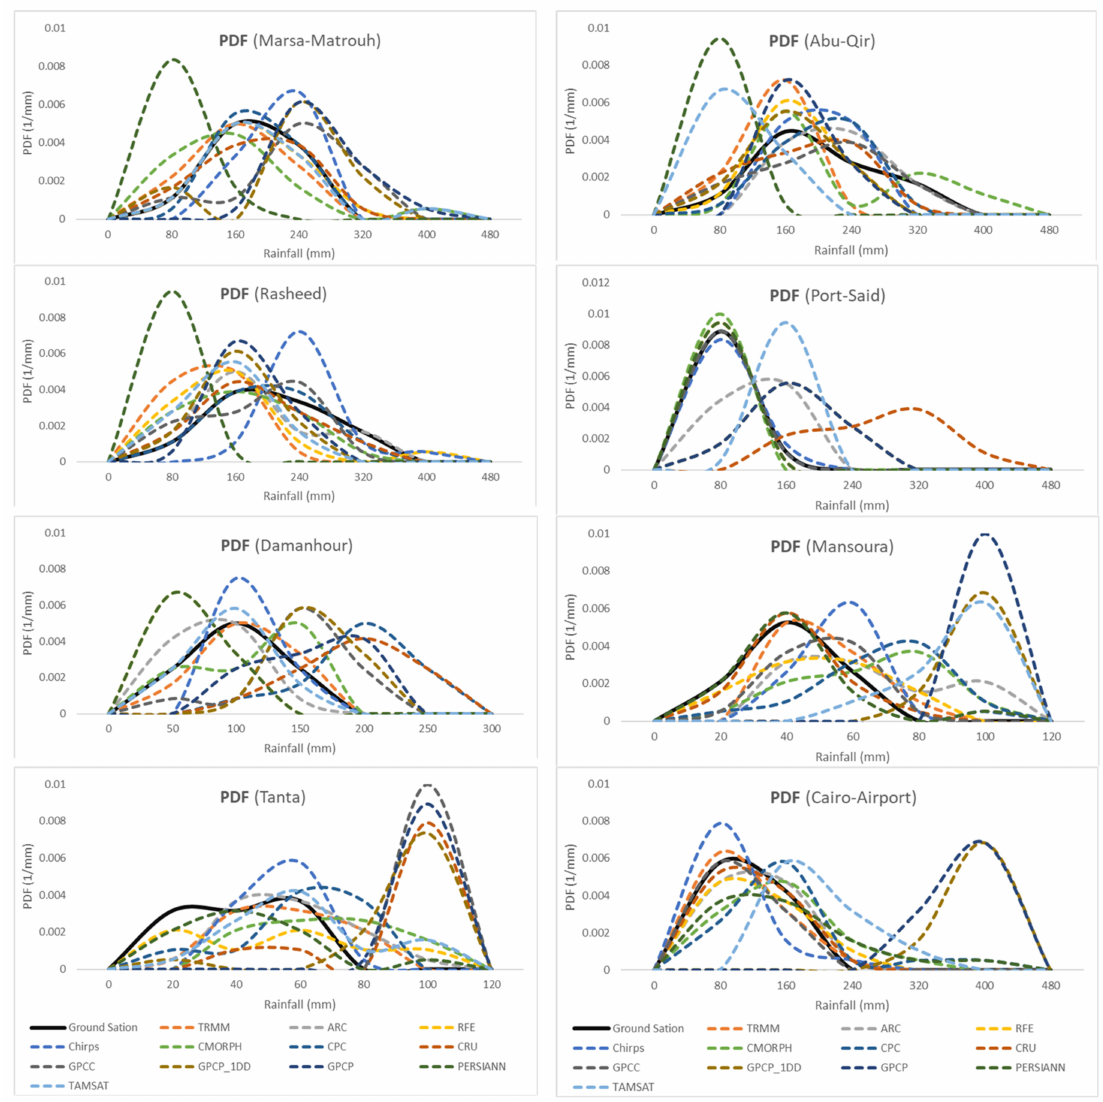
Figure 3. Probability density function (PDF) plot of annual